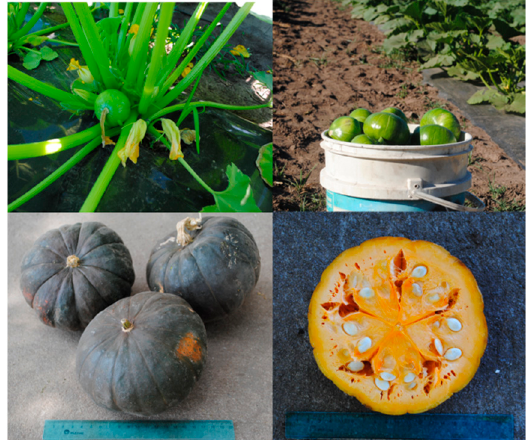
Figure 9. Upper row, Zapallito cultivar ‐ group bush plant at anthesis and bucket at harvest. Lower row, entire and sliced mature fruits bearing typical thin spongy light colored flesh. Blue ruler length 20 cm.